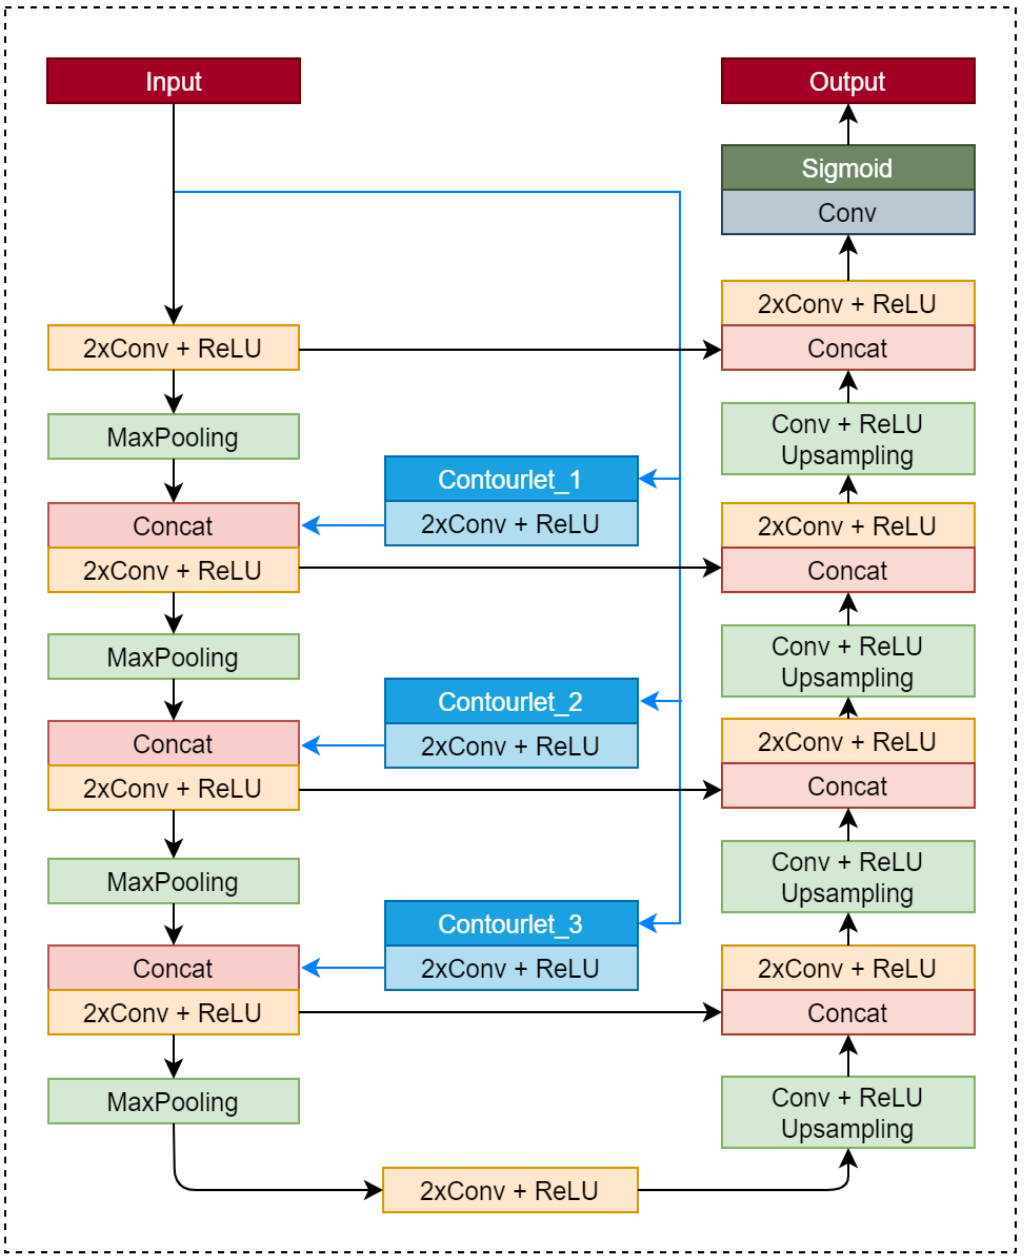
Figure 2. Proposed composite architecture (Conv: Convolution layer; ReLU: Rectified Linear Unit; MaxPooling: Maximum Pooling; Concat: Concatenation; Contourlet_x: Contourlet decomposed subband at level x)